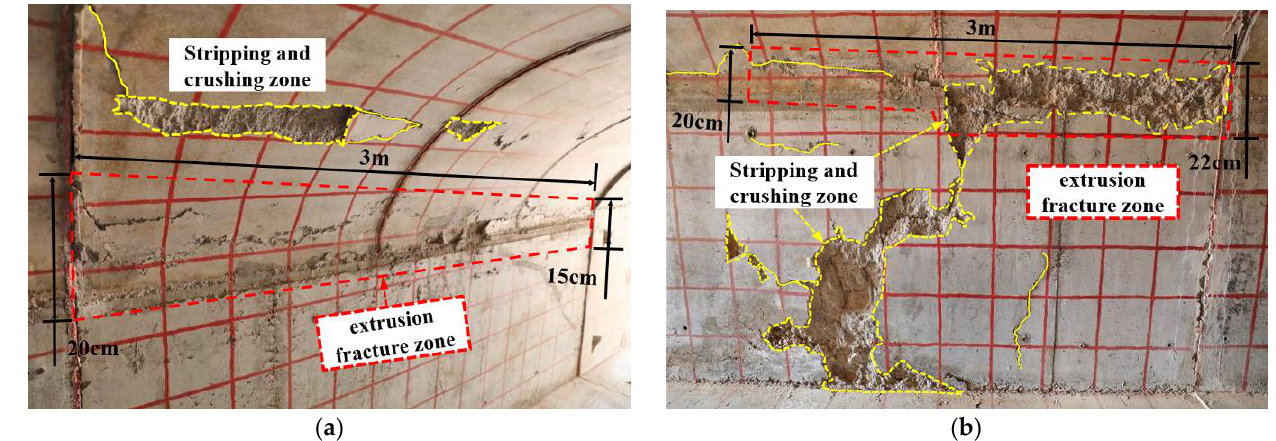
Figure 10. The damage states of the left arch spring and the right one: ( a ) the left arch spring; ( b ) the right arch spring.